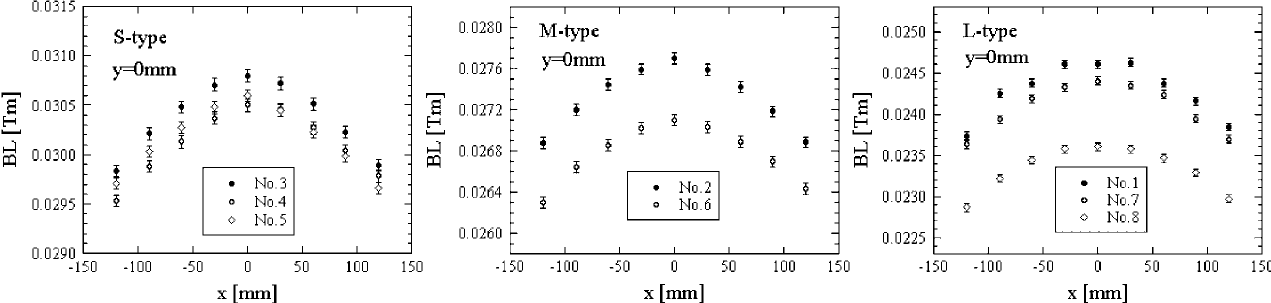
FIG. 5. The integrated magnetic field distribution for each magnet type at y ¼ 0 . The definition of each axis is shown in Fig. 3. Numbers 1 to 8 in the graphs refer to the magnet number described in Table I. Each data point has a (cid:1) 0 : 2% error bar.